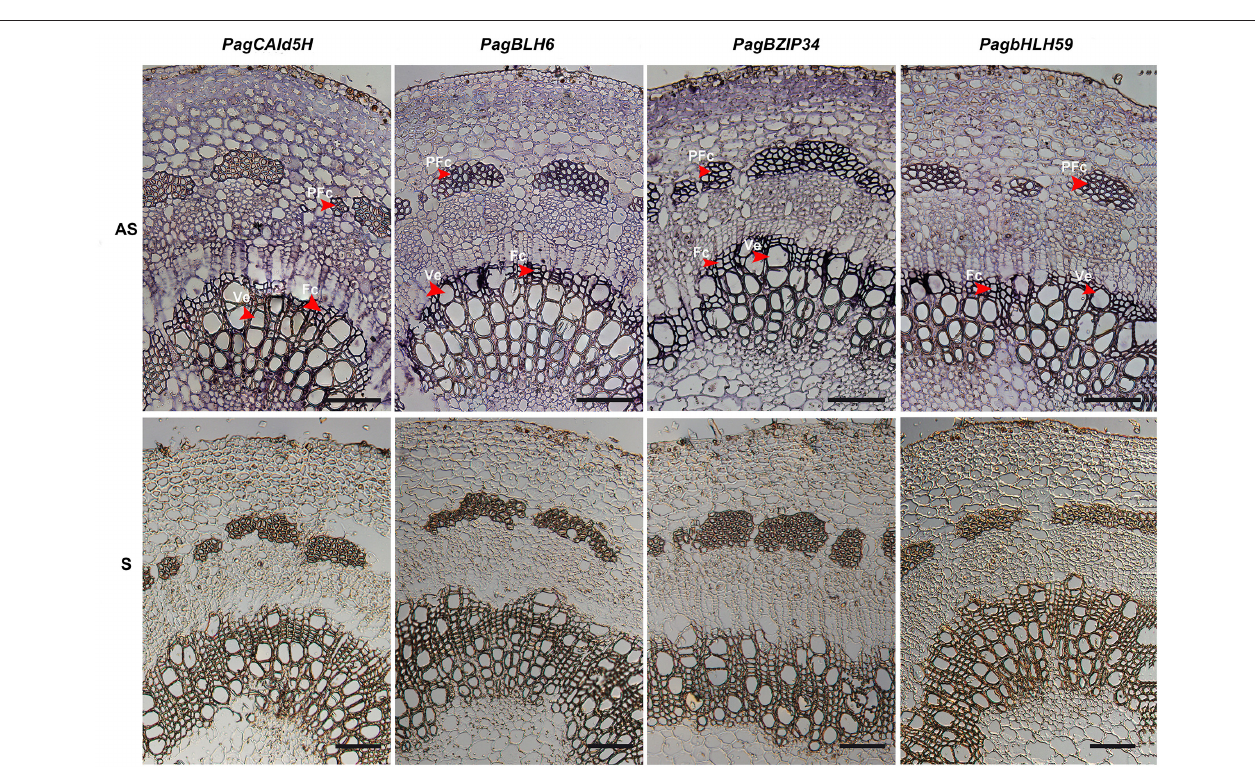
FIGURE 4 | RNA in situ localization of CAld5H , BLH6 , BZIP34 , and bHLH59 in the 8–9 internode stems of P. alba × P. glandulosa stems . Bars = 200 µ m. Arrows show the signals of the vessels (Ve), fiber cells (Fc), and phloem fiber cell (PFc) in the differentiating xylem where signals of RNA in situ hybridization were intensified. AS and S represent the sections hybridized with antisense and sense probes,